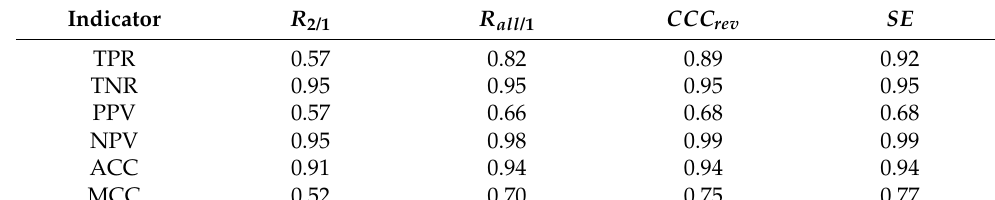
Table 6. Metric statistical indicators for hypothesis 2 .